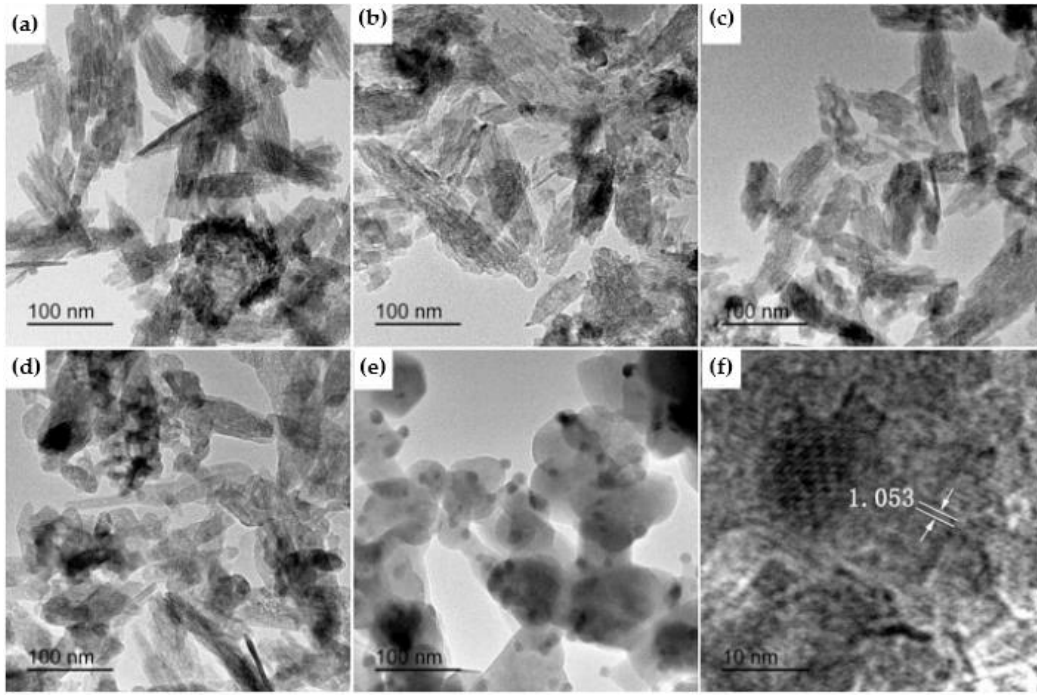
Figure 8. TEM of 6 mol % Tb-HA calcined at different temperatures: ( a ) 300 °C, ( b ) 400 °C, ( c ) 500 °C, ( d ) 600 °C, and ( e ) 700 °C; ( f ) HRTEM image of Tb-HA calcined at 700 °C [61] .